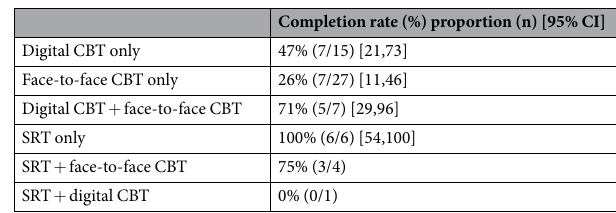
Table 2. Completion rates and uptake for participant selected cognitive behavioural therapy treatment modality. Note: From 96 participants, 60 started at least one form of therapy for insomnia, 28 completed therapy (defined as 5 face-to-face CBT sessions, 6 sessions of digital CBT or 5 weeks of SRT), and 36 did not start therapy at our clinic. Completion rates are expressed as a percentage of the number of participants who completed against those who started CBT by treatment modality with 95% confidence intervals. Confidence intervals and are not calculated when the numerator is 3 or fewer because the rate is not statistically distinguishable from zero. CBT: cognitive behaviour therapy; I-NSD: Insomnia with normal sleep duration; I-SSD: Insomnia with short sleep duration; SRT: sleep restriction therapy.